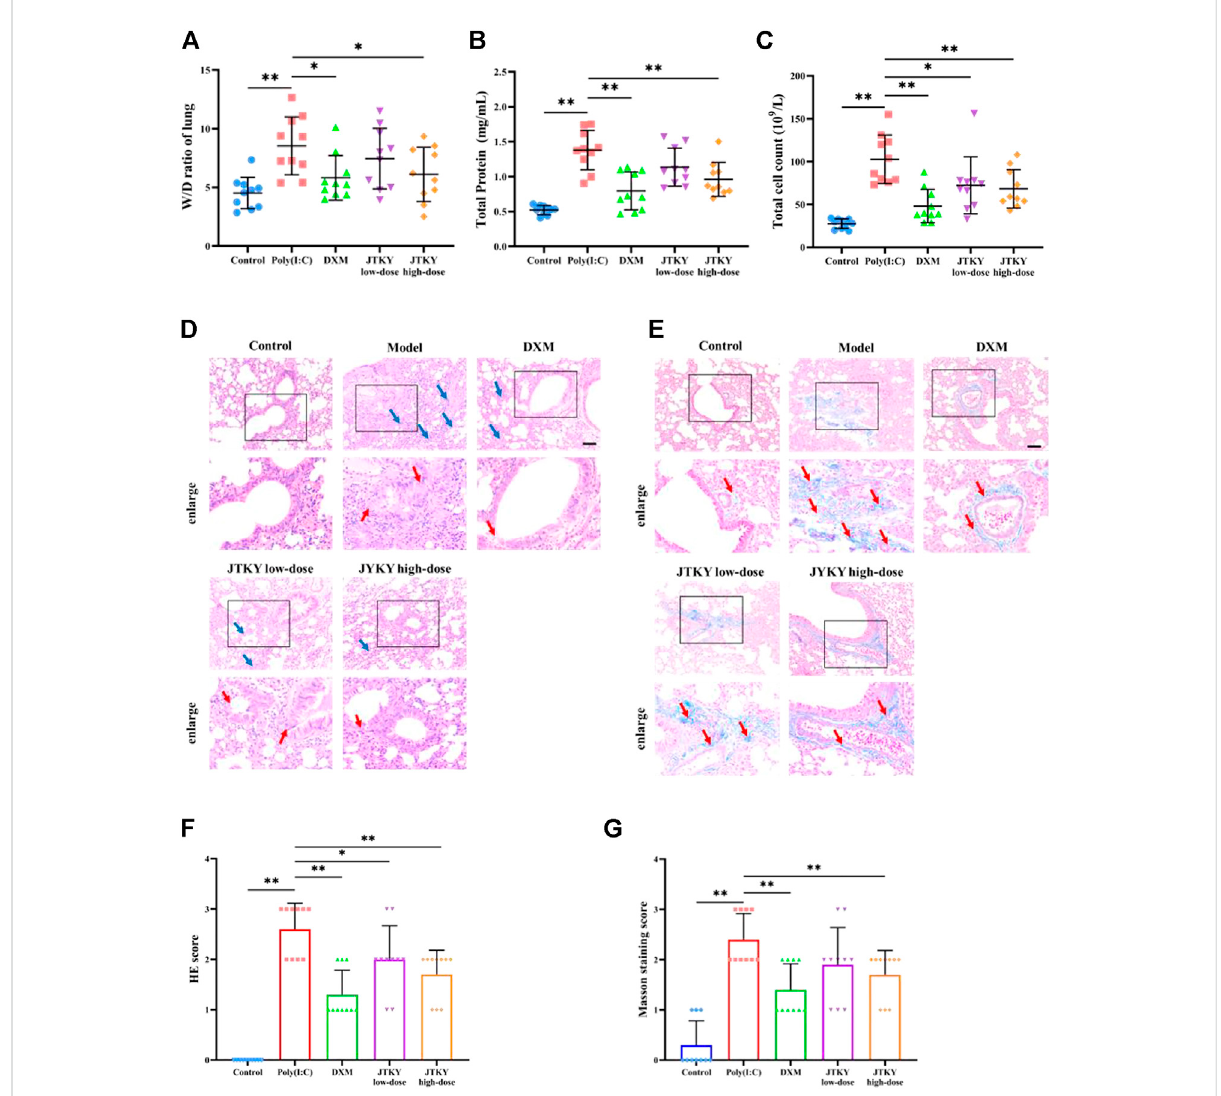
FIGURE 1 JTKY ameliorated poly(I:C)-induced viral pneumonia. (A) JTKY treatment decreased the W/D ratio in lung tissue. (B) JTKY treatment decreased the total protein concentration in BALF. (C) JTKY treatment decreased the total cell count in BALF. (D, F) HE staining indicated that JTKY treatment alleviated the pathological changes and decreased the in fl ammation score in lung (100 and ×200), blue arrows indicated the in fi ltration of in fl ammatory cells and red arrows indicated the damage of bronchial epithelial structure. (E, G) Masson staining showed that JTKY treatment decreased the collagen contents in lung (100 and ×200), red arrows indicated the accumulation of collagen contents. Control, Poly(I:C), DXM, JTKY low-dose and JTKY high-dose groups ( n = 10 per group). *: p < 0.05; **: p <